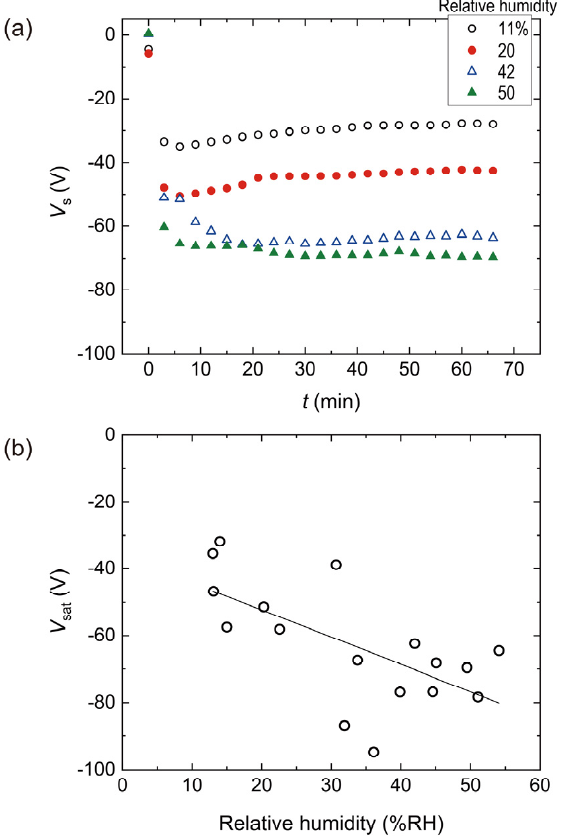
Figure 3. ( a ) Triboelectric charging behavior of the polyester (PES) single film when charged with iron powder beads under various humidity conditions. ( b ) Plot of saturated surface potential ( V sat ) versus relative